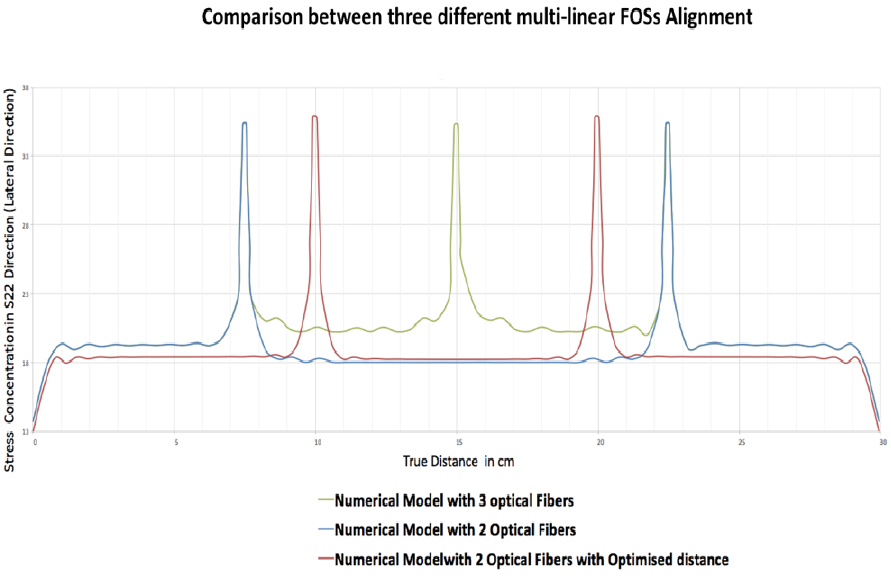
Figure 12. Comparison between three different multi-linear FOSs placements. Figure 12 . Comparison between three different multi-linear FOSs placements.